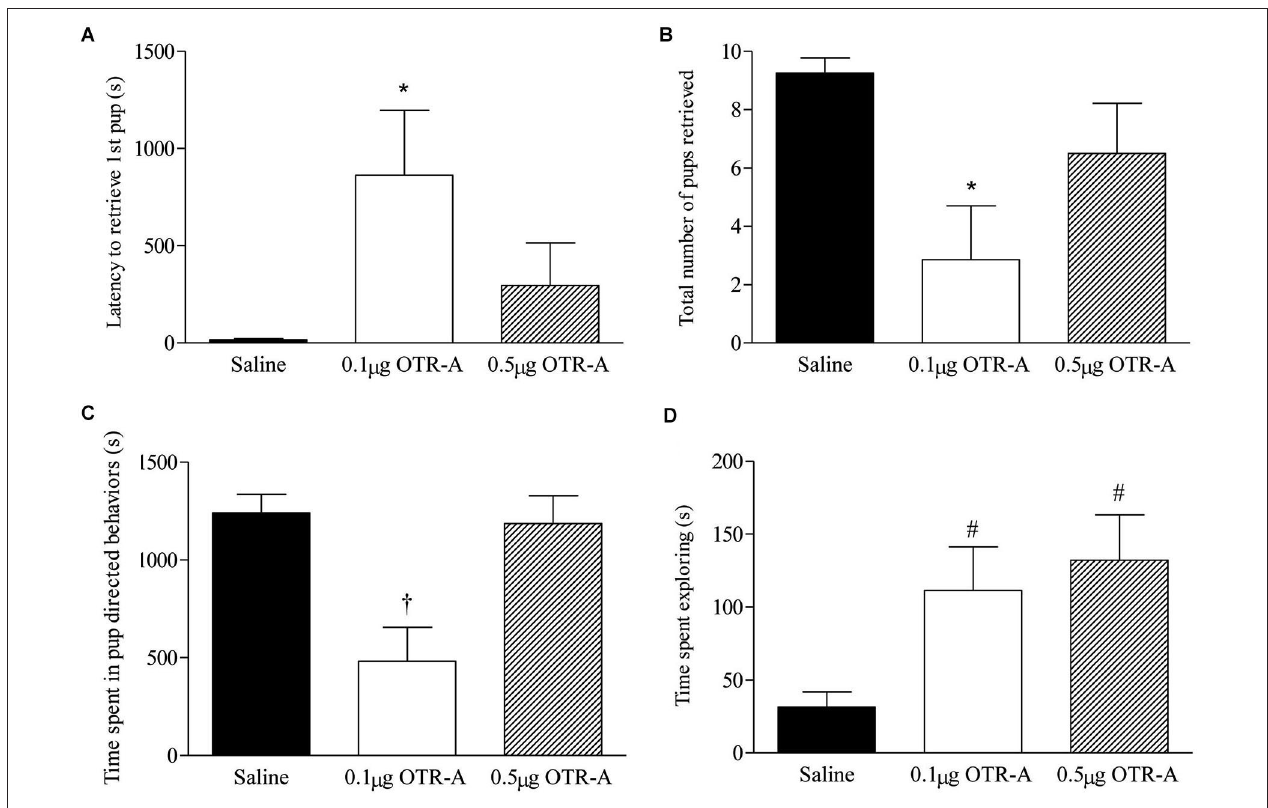
directed behaviors (C) . Both the low and high dose of OTR-A increased home cage exploratory behavior (D) . Bars represent mean ± SEM; * P < 0.05 0.1 µ g/ µ l OTR-A vs. saline, † P < 0.05 0.1 µ g/ µ l OTR-A vs. saline and 0.5 µ g/ µ l OTR-A, # P < 0.05 0.1 µ g/ µ l OTR-A and 0.5 µ g/ µ l OTR-A vs. saline.